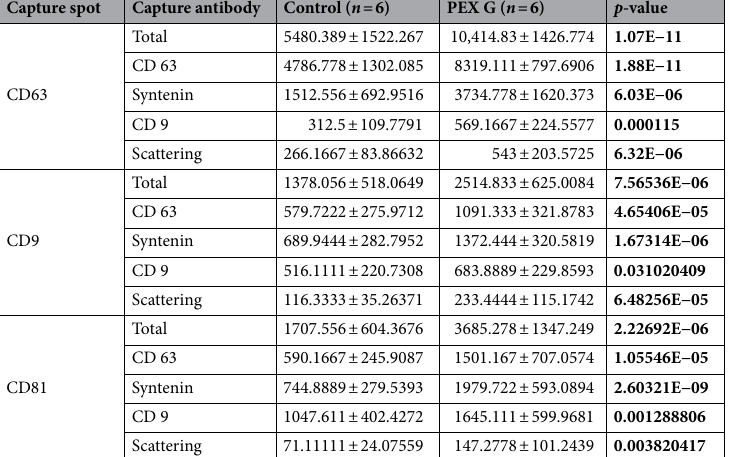
Capture spot Capture antibody Control ( n =